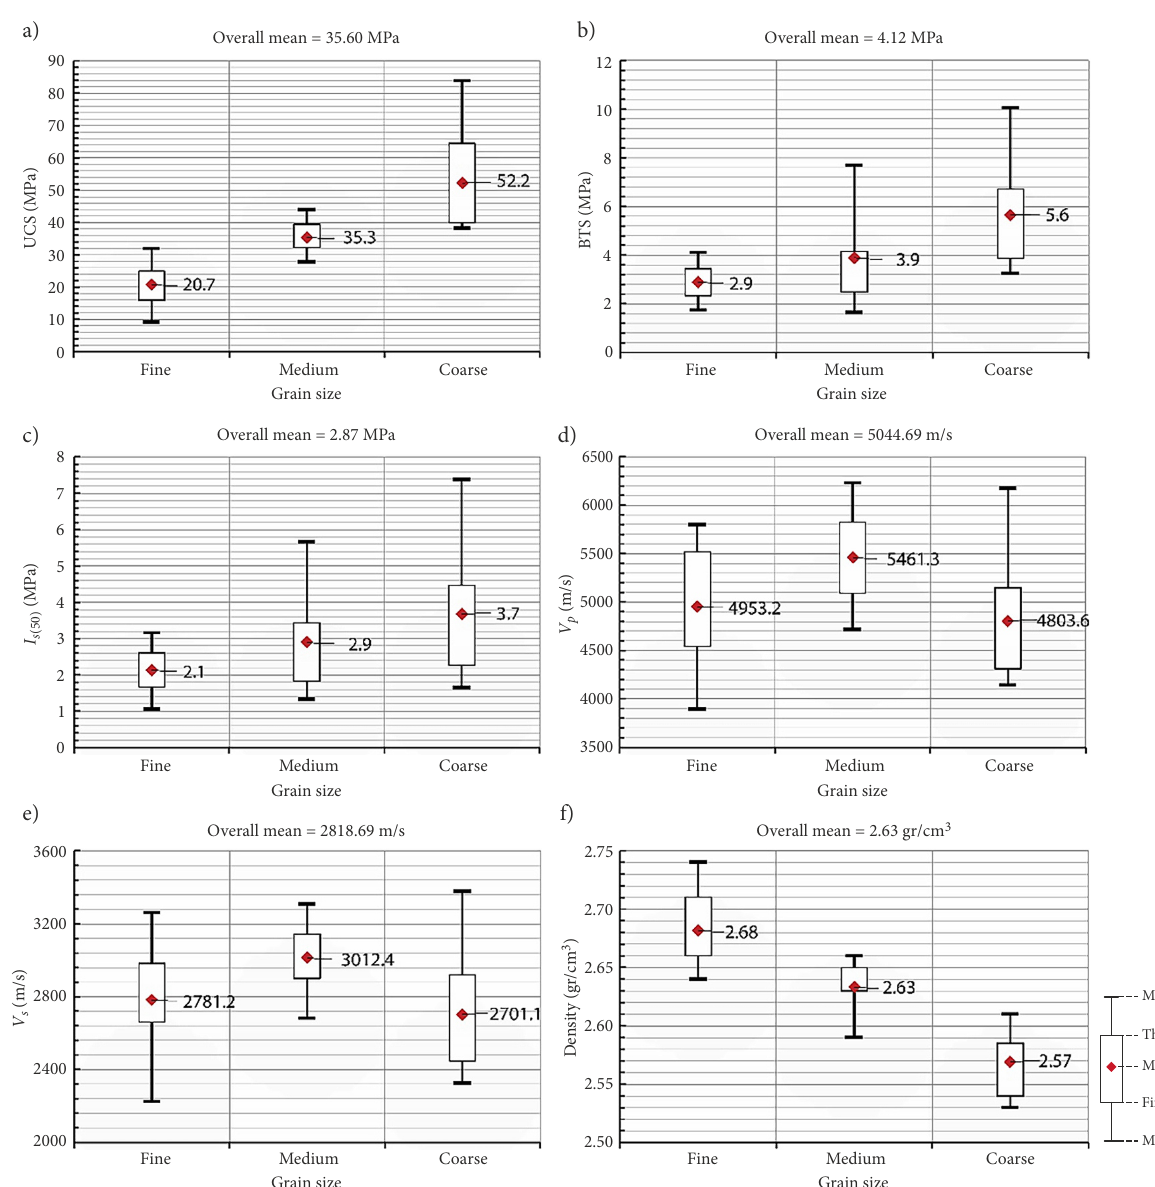
Figure 5. Effect of grain size on the mechanical and physical properties of the dolomite samples. grain size versus: (a) Uniaxial compressive strength (UCS); (b) Brazilian tensile strength (BTS); (c) Point load strength ( I s (50) ); (d) P-wave velocity ( V p ); (e) S-wave velocity ( V s ); and (f)